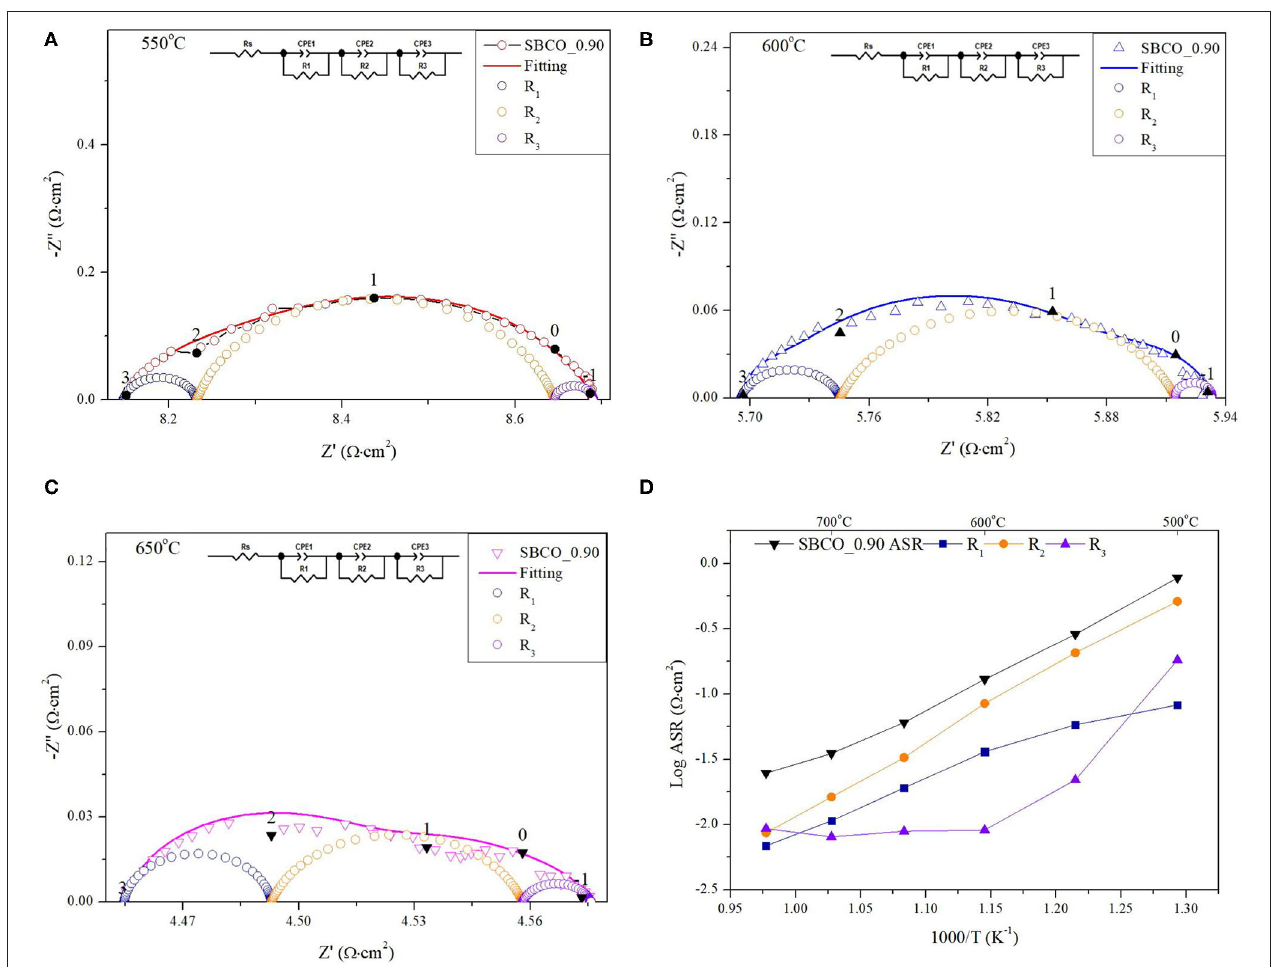
FIGURE 3 | Impedance plots of Sm 0.90 BaCo 2 O 5 + d measured at (A) 550 ◦ C, (B) 600 ◦ C, and (C) 650 ◦ C with equivalent circuit in inset. (D) shows ASR calculated from R 1 ( ), R 2 ( ), and R 3 ( ) of equivalent circuit; total ASRs are shown as (